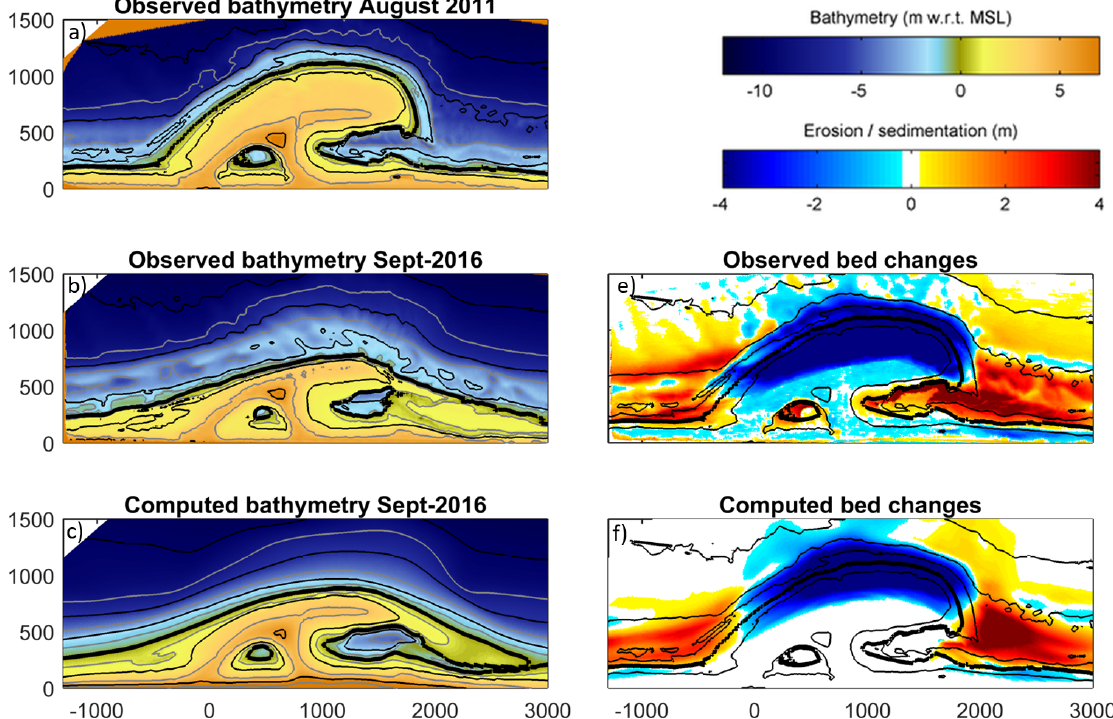
Figure 6. Overview of observed and computed bed levels and changes for 2016. ( a ) presents the observed bed levels in August 2011, ( b ) shows the observed bed levels in September 2016, ( c ) presents the computed bed levels in September 2016, while the observed and computed bed changes are presented in ( e ) and ( f ),